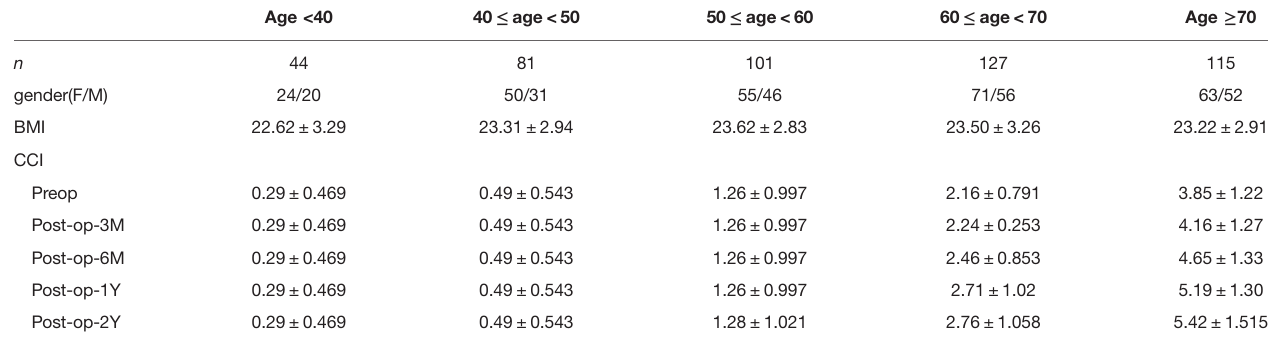
TABLE 1 | Changes of preoperative CCI in different age